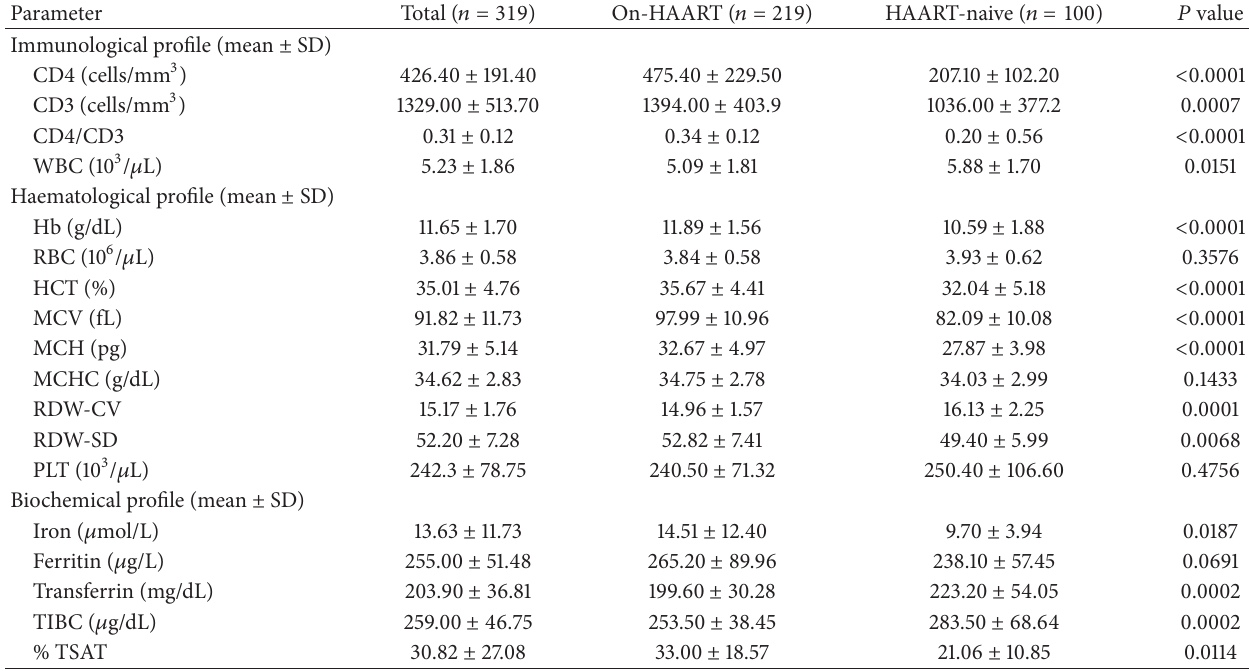
Table 2: Immunological, haematological, and biochemical profiles of the study population stratified by HAART status.